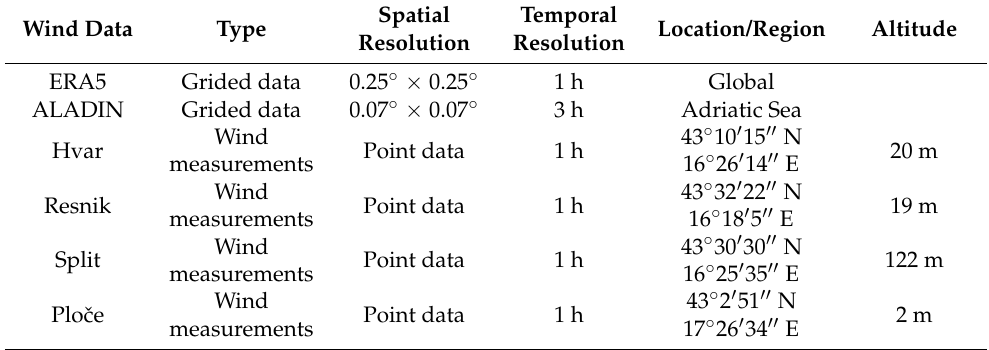
Table 2. Wind data sources used in this study with corresponding spatial and temporal resolutions. Wind